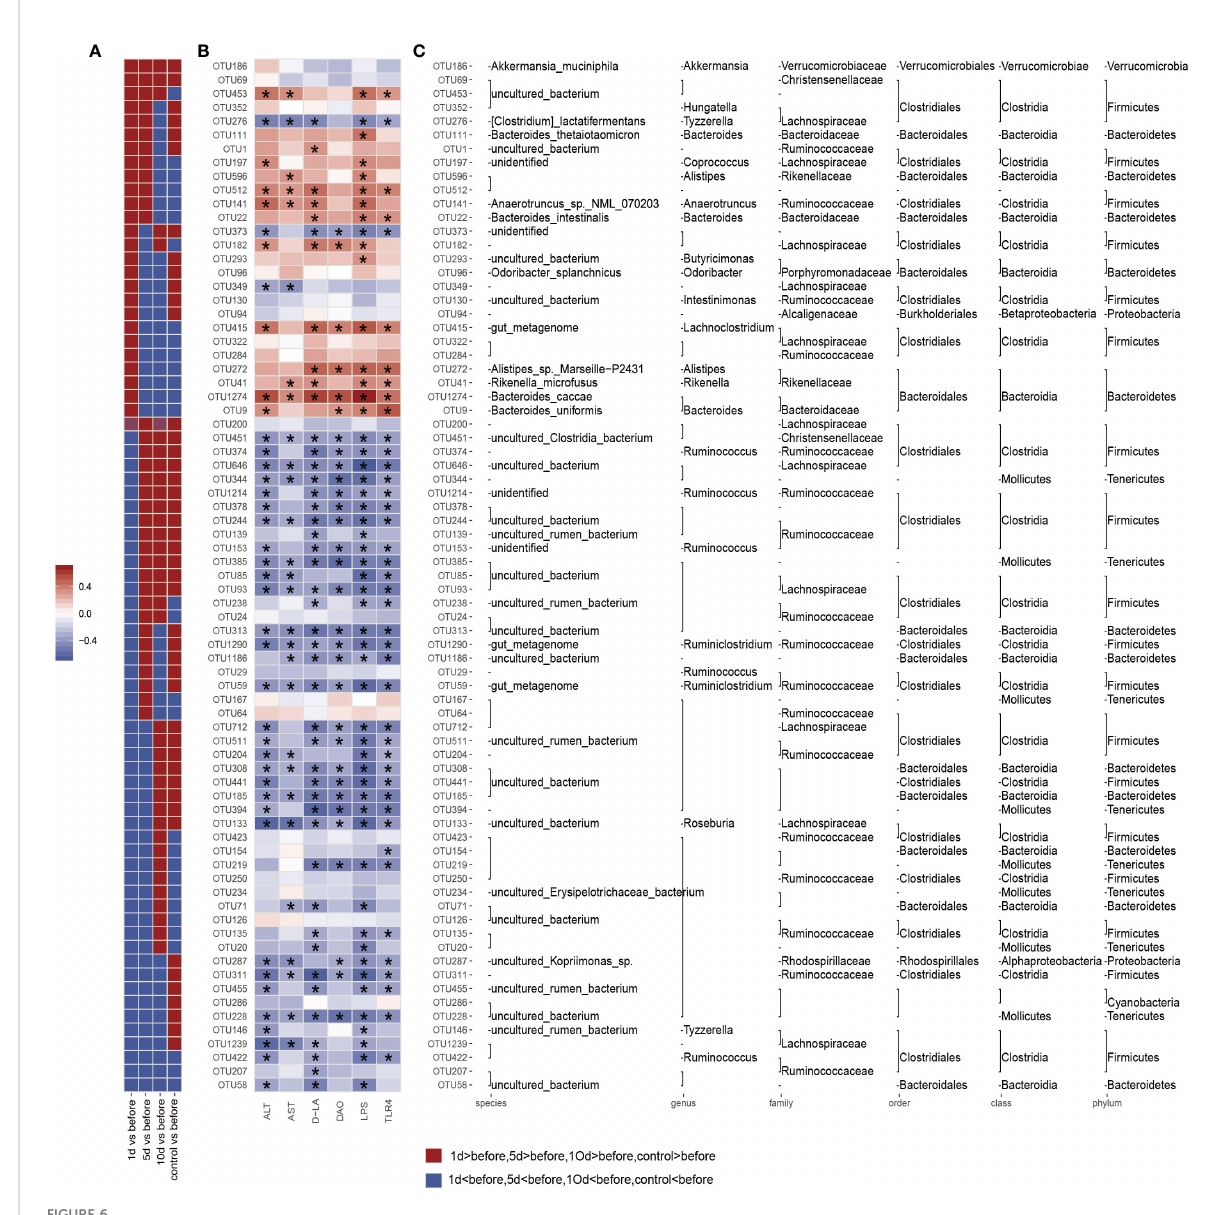
FIGURE 6 Correlation analysis based on fl ora operational taxonomic units (OTUs) and clinical factors. The color intensity indicates the correlation degree between OTU abundance and principal parameters which were evaluated by Spearman ’ s correlation analyses. The top 75 OTUs, with statistically signi fi cant abundance differences by Spearman ’ s correlation analyses with speci fi c metabolic parameters in groups. Signi fi cantly different clinical factor changes are marked with an asterisk (*) (p < 0.05). (A) OTUs abundance changes. Red and blue showing the OTUs abundance with more and less abundant in HCs and postoperative group in different time window groups relative to the before group. (B) Correlations between 75 OTUs and host metabolic parameters. Color intensity represents the level of association between OTU abundance and principal parameters, as assessed by Spearman's correlation analyses. Rows correspond to OTUs with identities on the left, and columns correspond to serum parameters. Positive and negative associations are shown in red and blue. The asterisk (*) indicates signi fi cant difference (p < 0.05). (C) OTU taxonomy is shown on the right. OTUs whose abundance was altered by tumor models and then signi fi cantly reversed by transcatheter arterial chemoembolization